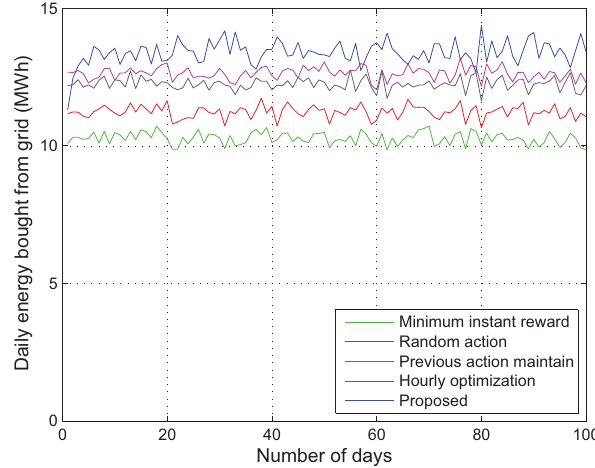
Figure 7. Amount of energy bought daily from utility with respect to time in days.